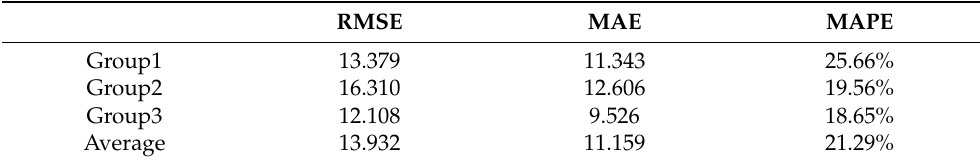
Table 8. Random forest prediction performance under the test set.